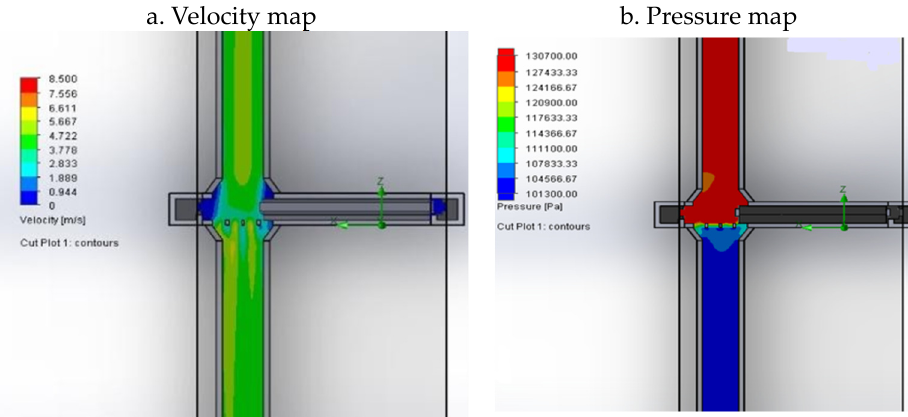
Figure 20. Third valve geometry with 70% opening.